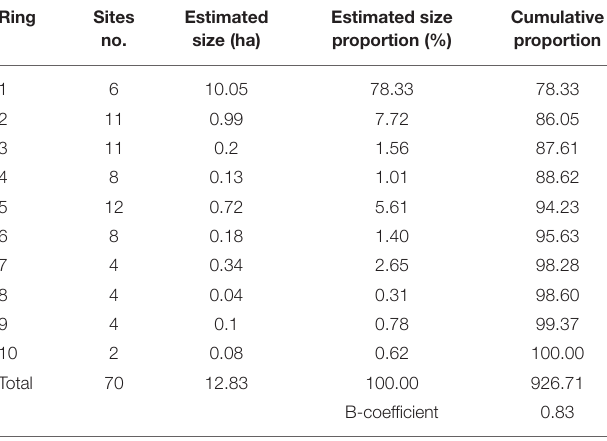
TABLE 12 | Calculation of B-coefficient for Tuscania in the Archaic period. Ring Sites Estimated Estimated size no. size (ha) proportion (%)